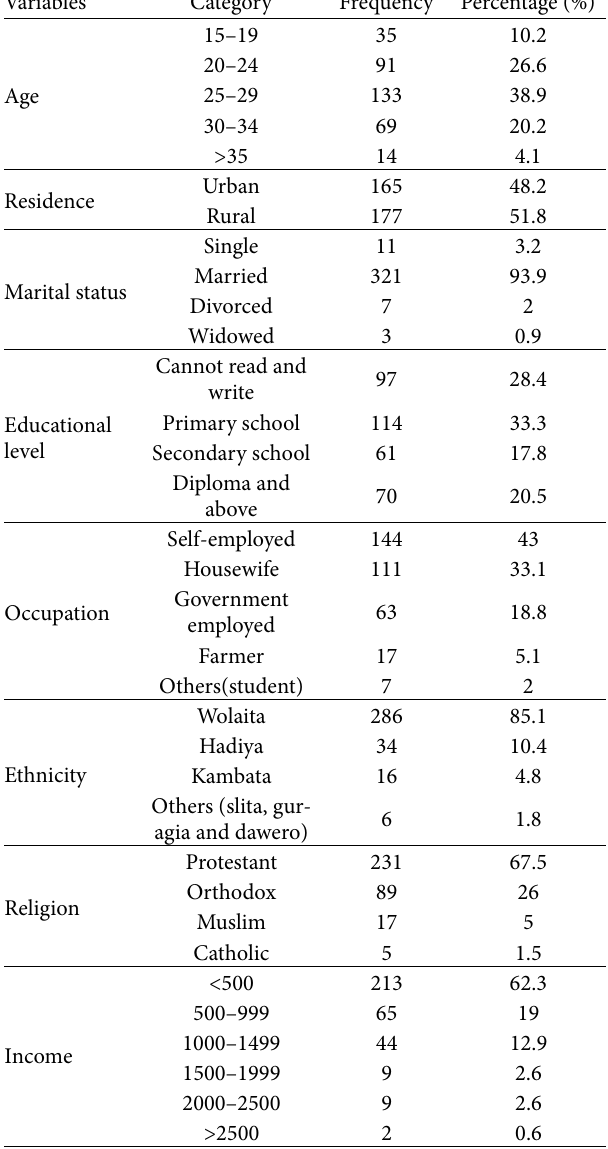
Table 2: Mothers distribution by the number of children they have at the Gununo health center, Wolaita zone, SNNP region, Southern